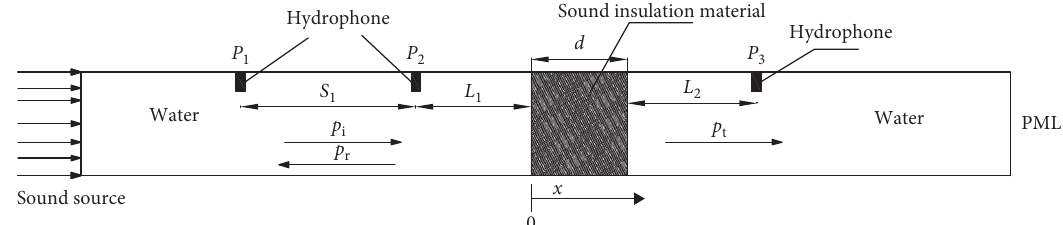
Figure 1: The three-hydrophone transfer function method is used in the simulation.